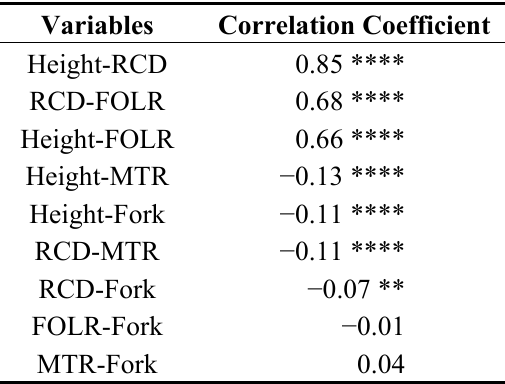
Table 5. Pearson correlation coefficients for height, root-collar diameter (RCD), number of first-order lateral roots (FOLR), and occurrence of missing taproot (MTR) and stem forks (Fork), ( n = 1589 for correlations with number of FOLR and n = 1741 for the remaining of